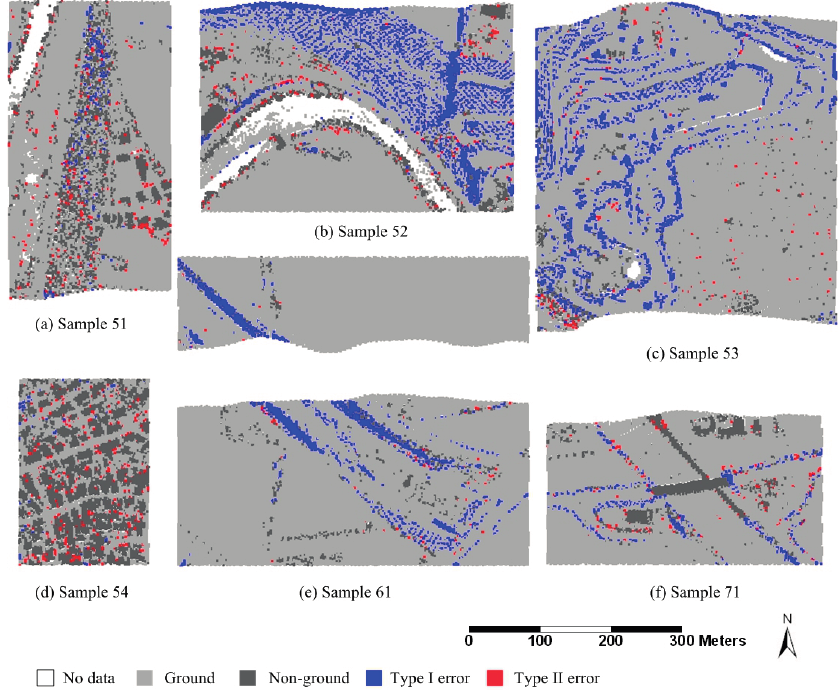
Figure 11. Spatial distribution of errors generated by filtering rural sample